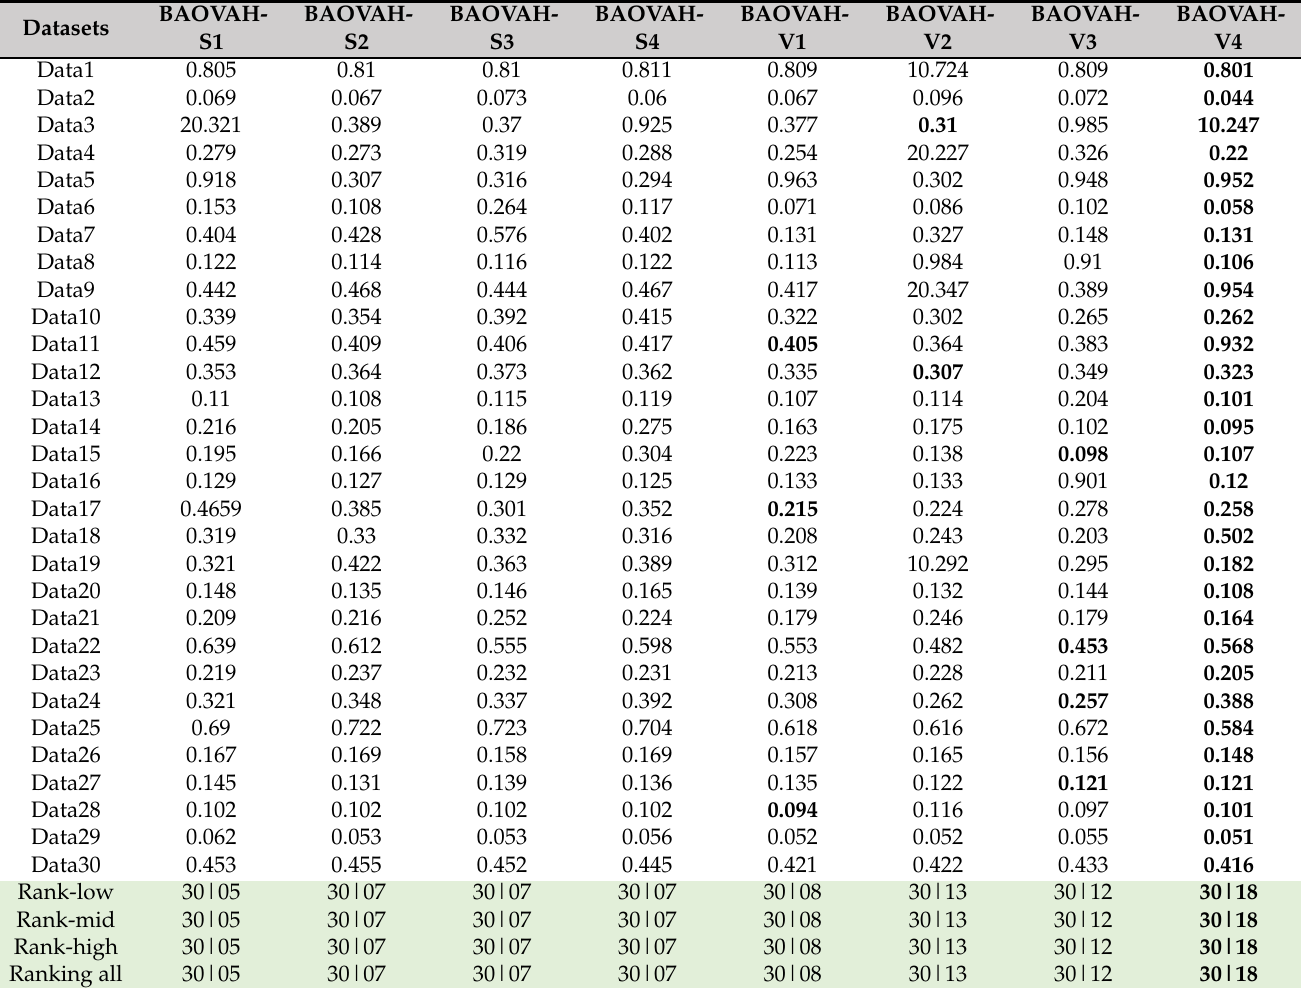
Table 5. Comparison of proposed BAOVA methods based on Z-shaped and V-shaped based on the average objective function